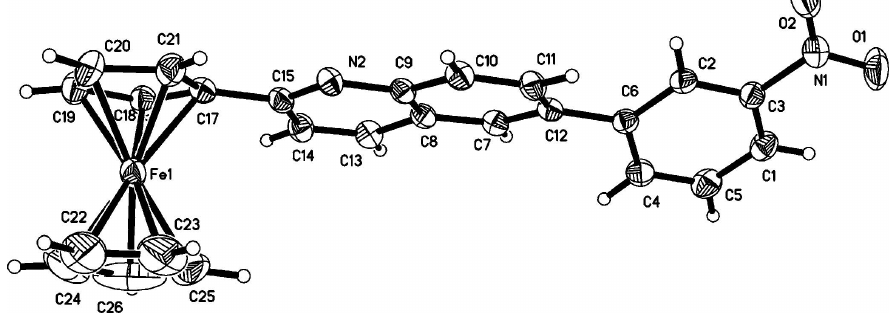
Figure 1 The molecular structure of the title compound with displacement ellipsoids at the 30% probability